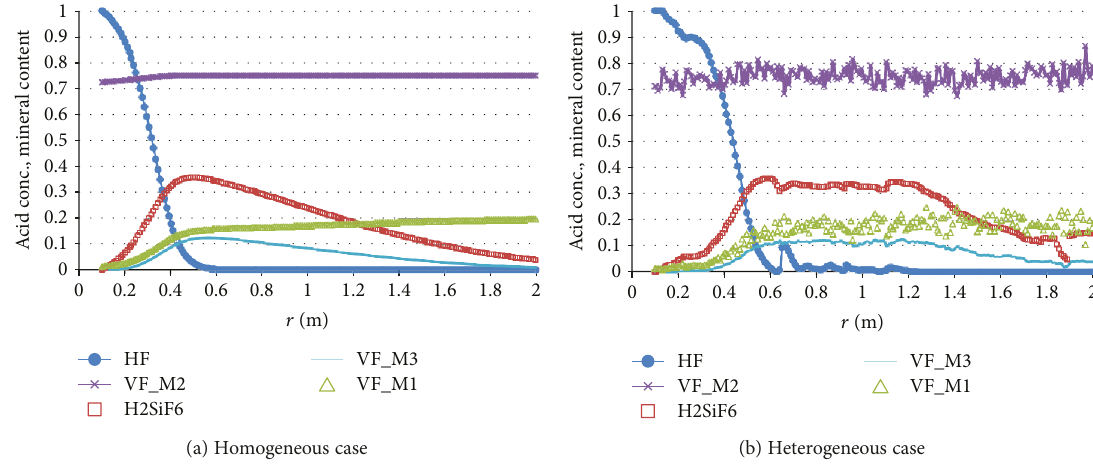
Figure 5: Mineral and acid concentration distribution in radial direction.